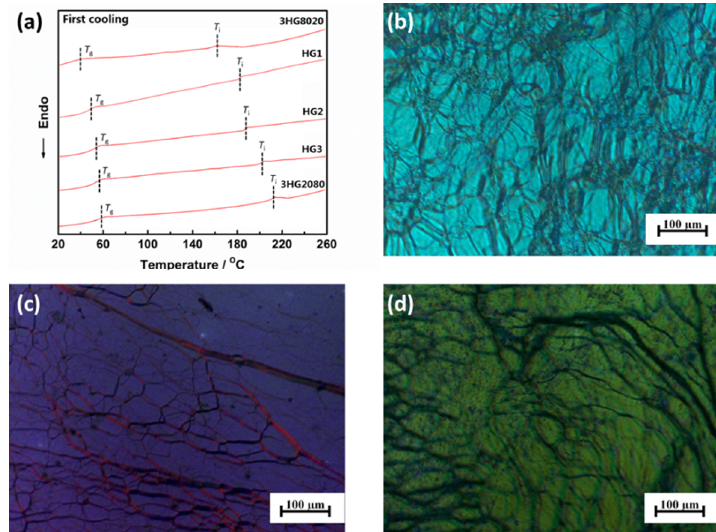
Figure 3. ( a ) Di ff erential scanning calorimetry curves of samples 3HG8020, HG1, HG2, HG3, Figure 3. ( a ) Differential scanning calorimetry curves of samples 3HG8020, HG1, HG2, HG3, and and 3HG2080 during the first cooling scan at a rate of 20 ◦ C min − 1 . Polarized optical microscopic 3HG2080 during the first cooling scan at a rate of 20 °C min −1 . Polarized optical microscopic images images of the samples at 90 ◦ C: ( b ) HG1; ( c ) HG2; and ( d ) of the samples at 90 °C: ( b ) HG1; ( c ) HG2; and ( d ) HG3.